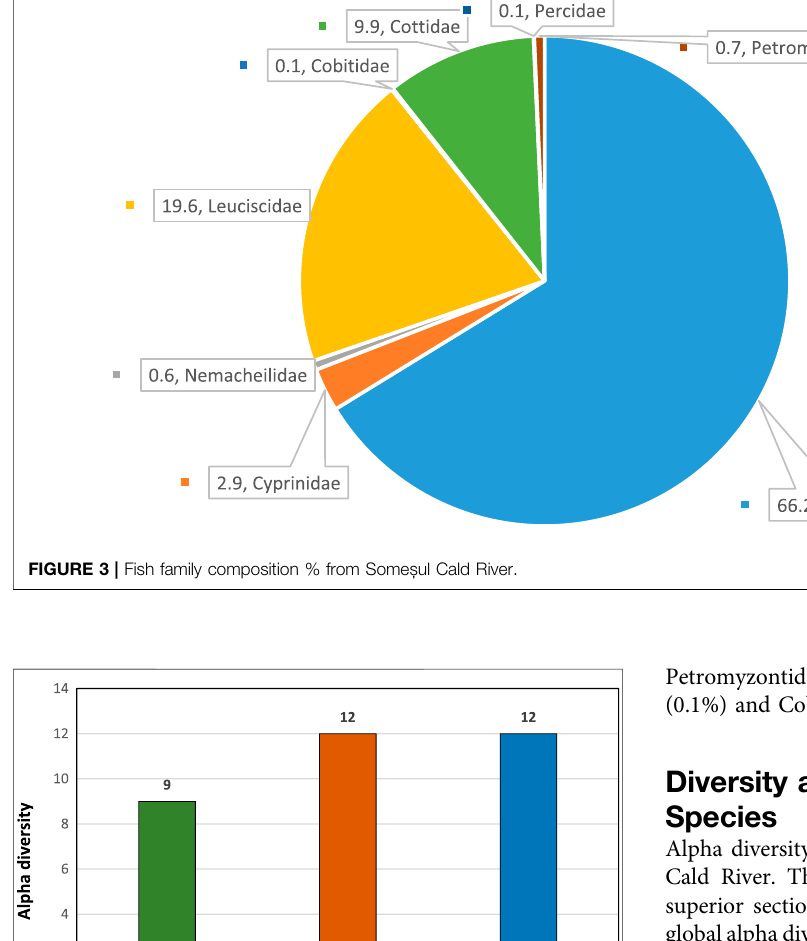
Frontiers in Environmental Science |